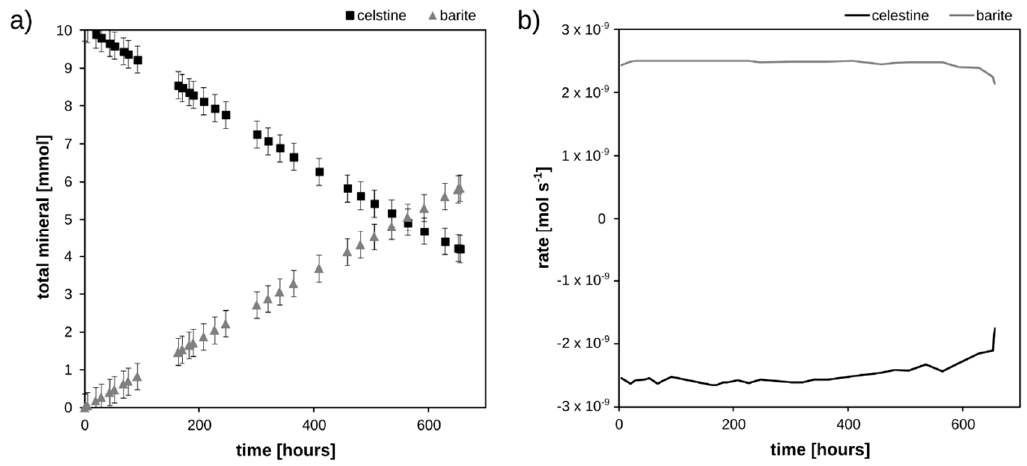
Figure 4. ( a ) Total amounts of minerals in the column, and ( b ) rates of barite precipitation and celestine dissolution as function of time.